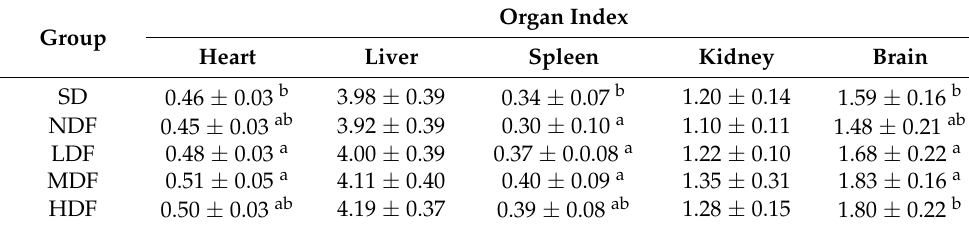
Table 3. Effect of CDFC on organ indices of aging